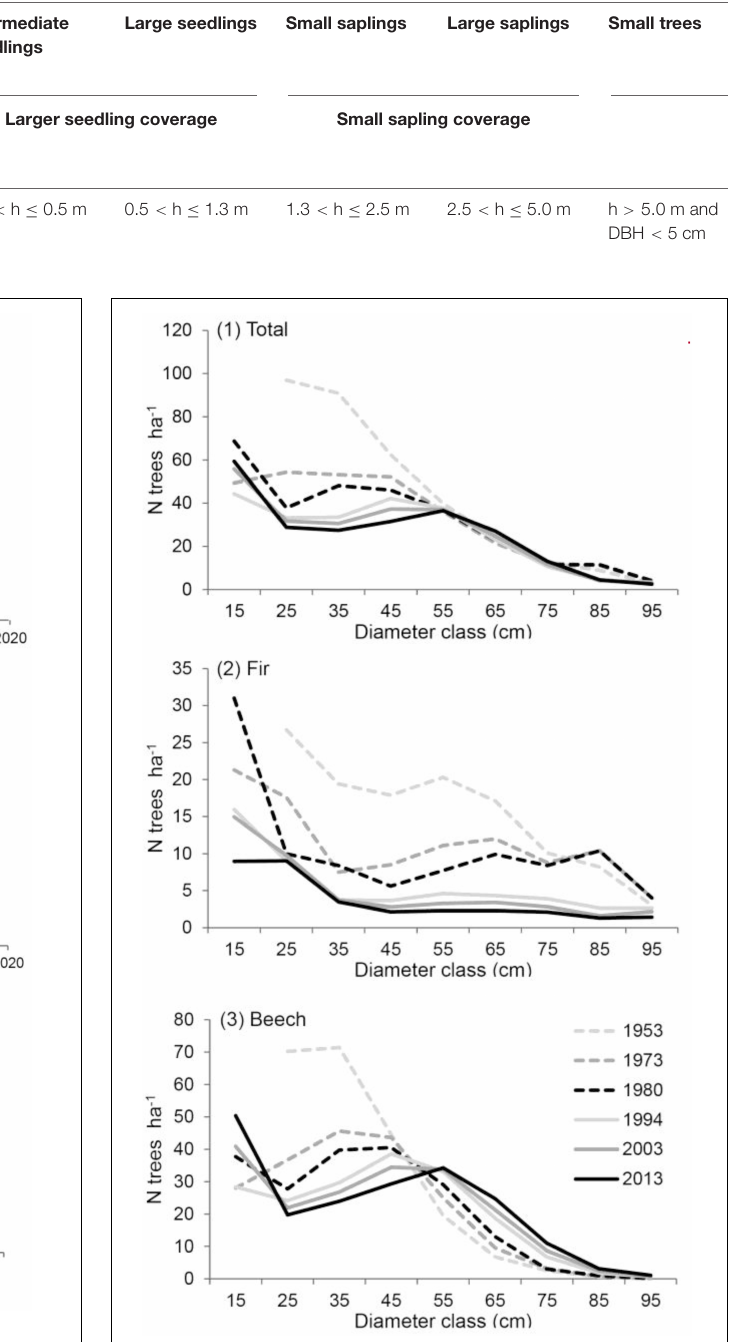
FIGURE 1 | (1) Dynamics and structure of growing stock in the last half century, (2) decrease in the proportion of silver fir in the growing stock over a 120-year period and (3) percentage of forest area per developmental